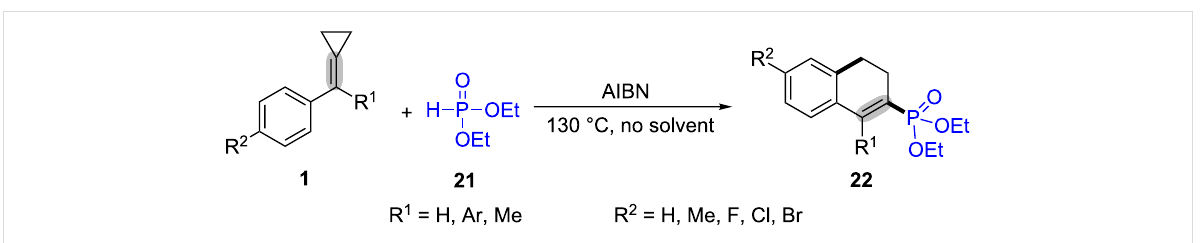
Scheme 7: AIBN-mediated oxidative radical ring-opening and cyclization of MCPs with diethyl phosphites.